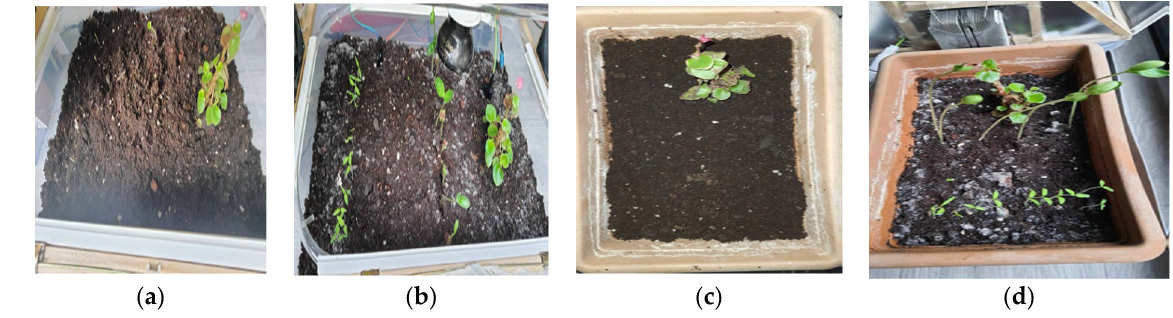
Figure 6. Developmental process of plants grown in the greenhouse ( a , b ) and in pots ( c , d ).